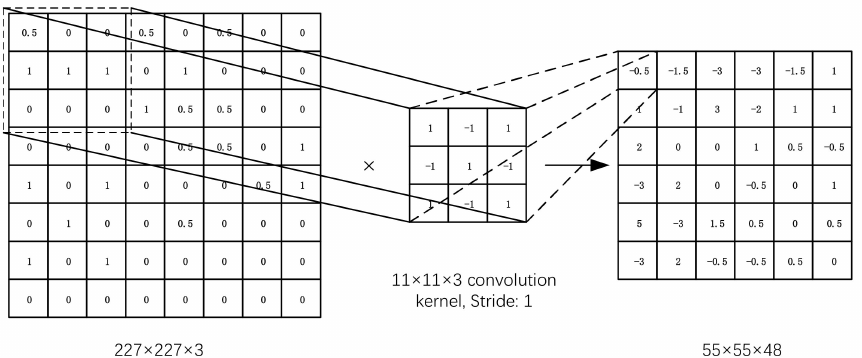
Figure 5. The process of